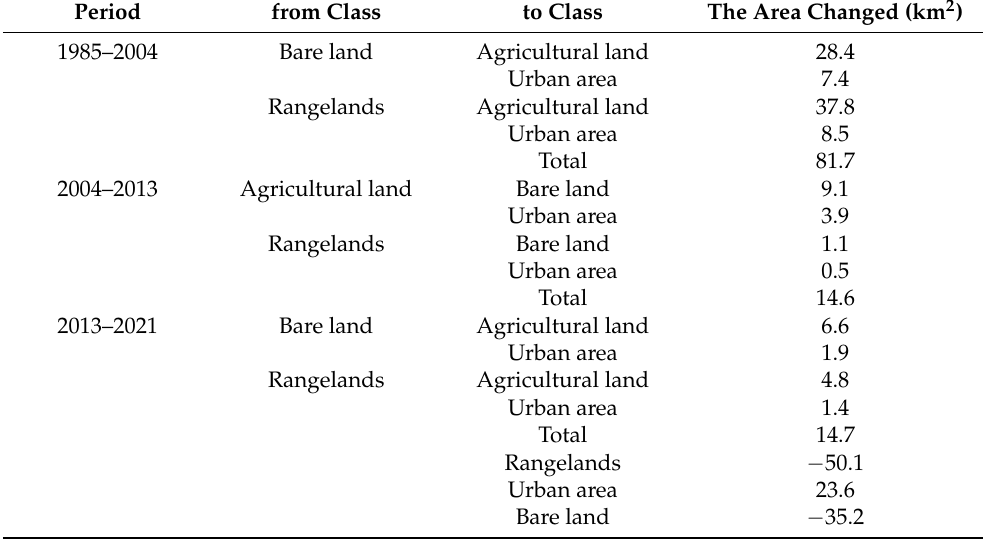
Table 6. Land use conversions in Irbid district for the three periods and during the overall study